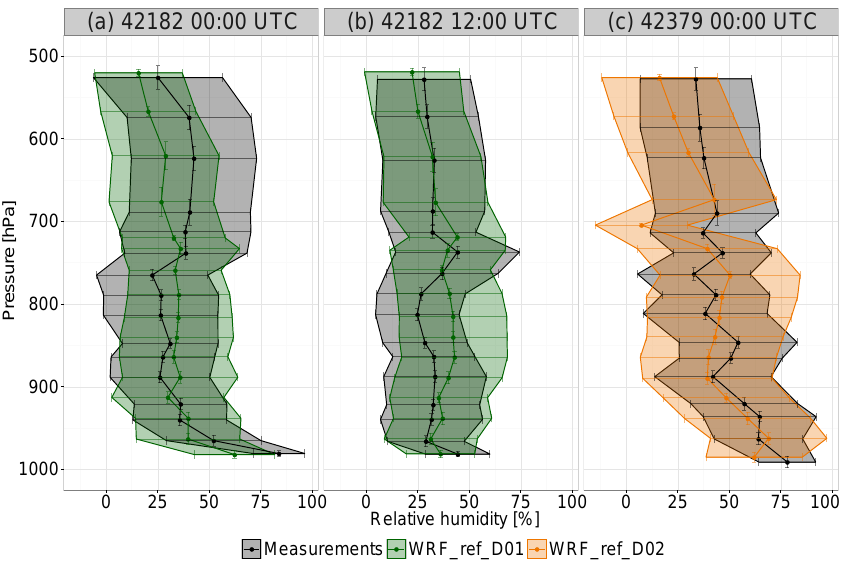
Figure 4. Averaged vertical profiles derived from radiosonde data and WRF simulations for relative humidity (%) for the period of January– June 2013. The figures show the results for station 42182 at 00:00UTC (a) and 12:00UTC (b) and station 42379 at 00:00UTC (c) . The shaded areas show the standard deviation, indicating the variability over the whole time period within each